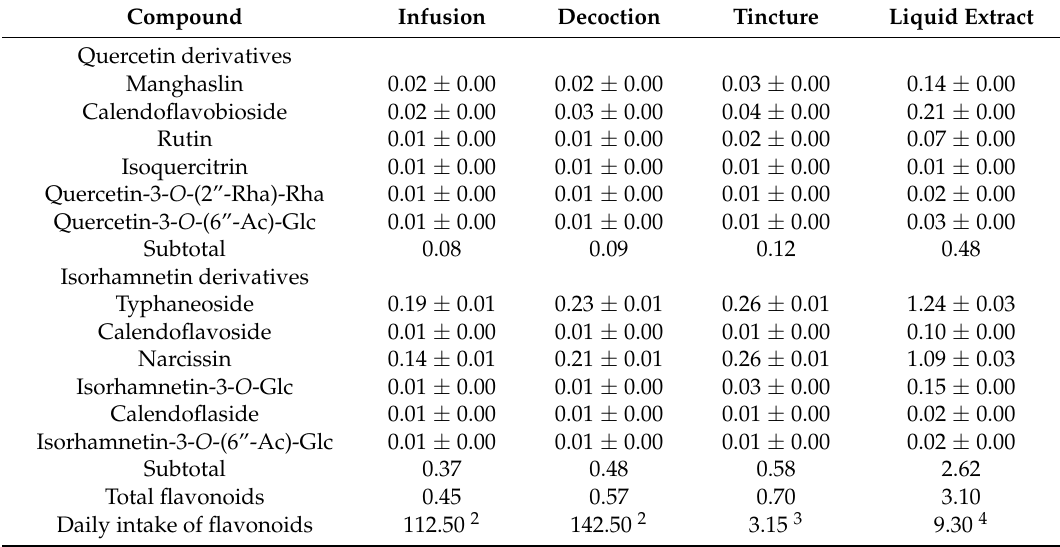
Table 5. Content of quercetin and isorhamnetin derivatives in liquid preparations of C.